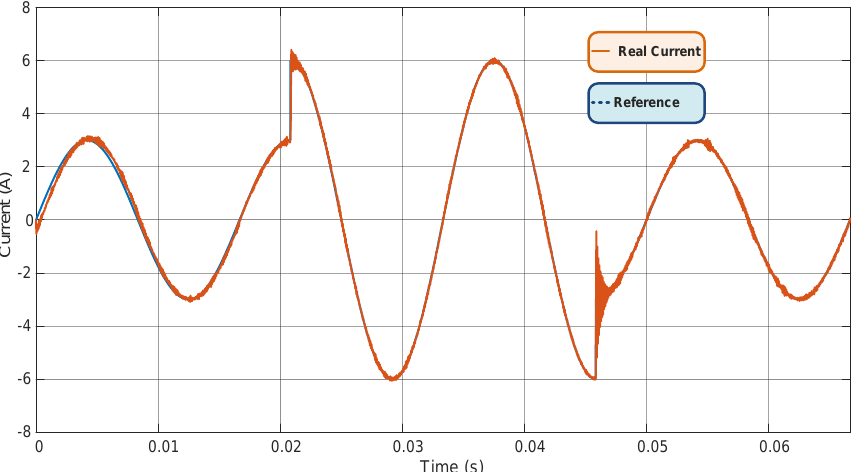
Figure 15. Comparison between currents 𝑖 2 and 𝑖 2 ∗ with SMC plus P + R.